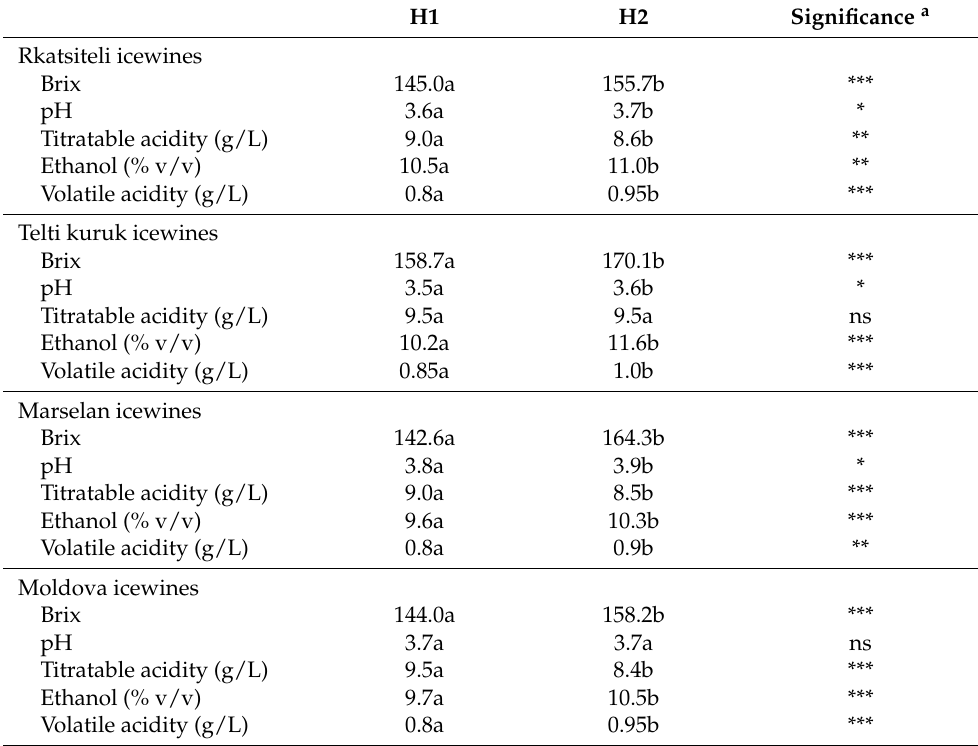
Table 4. Influence of harvest date (H1, H2) on the chemical compositions of the varietal experimen- tal